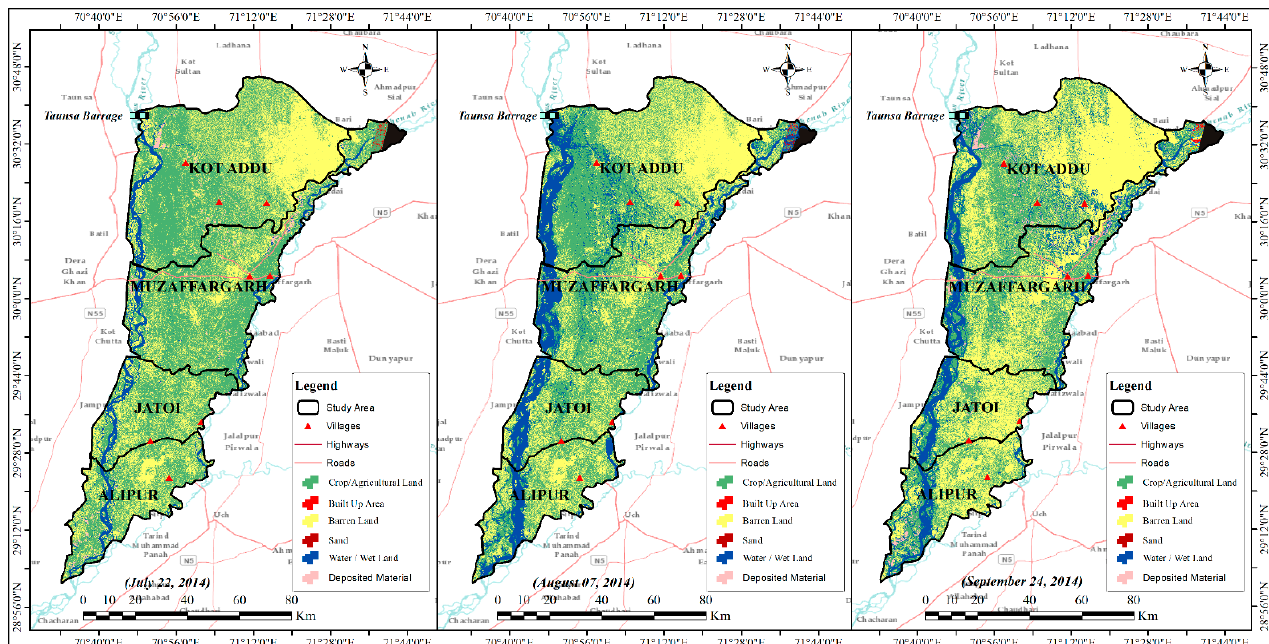
Figure 3. LULC classification of Muzaffargarh District before the flood ( left ), during ( middle ), and after ( right ) the 2014 flood as identified using Landsat images.